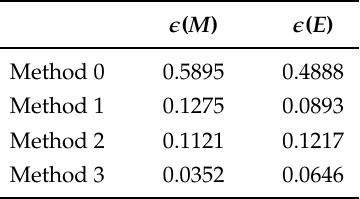
Figure 12. Particle locations for the fully resolved simulation, Method 0, Method 1, Method 2, and Method 3 at t = ( a ) 1, ( b ) 10, and ( c ) 100. Table 1. The mean absolute error of log β , where β is either M ( t ) or E ( t ) , for each of the upscaled 10 methods as defined by Equation